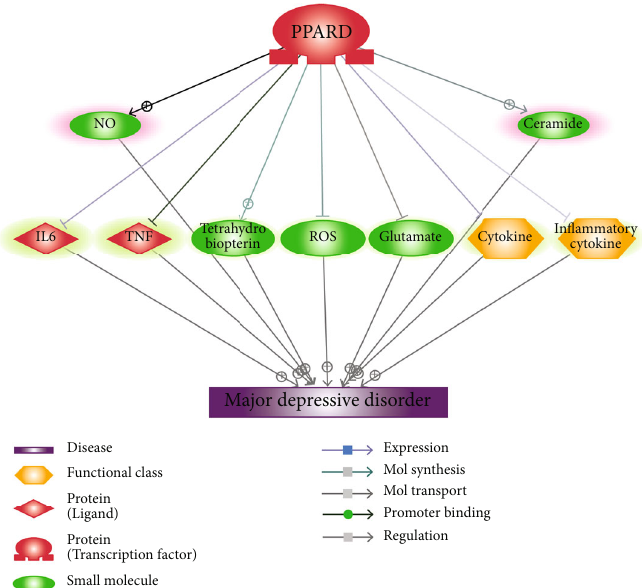
Figure 1: PPARD-driven pathways involved in the pathology of MDD. The pathway was built through Pathway Studio-assisted literature data mining, supported by over 400 references. The items highlighted in green are the ones that were driven by PPARD to suppress the development of MDD, and the red ones were regulated by PPARD to promote MDD